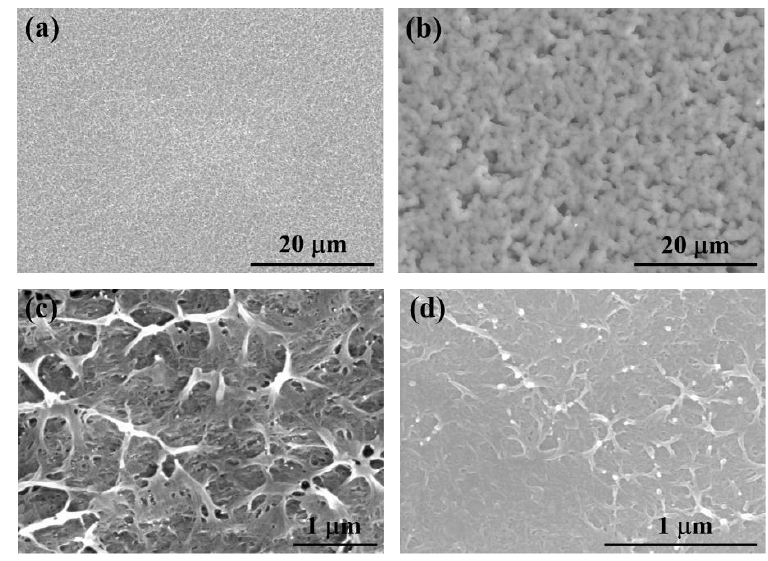
Figure 3. SEM images of ( a ) SPE-Zn, ( b ) ILPE-Zn-4, ( c ) SPE-Zn cross-section, and ( d ) ILPE-Zn-4 cross-section.